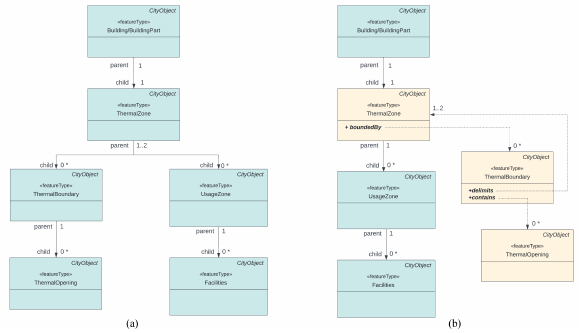
Figure 9. Relations among CityObjects (a) in the semi-direct translation, and (b) in the final version of the Extension.